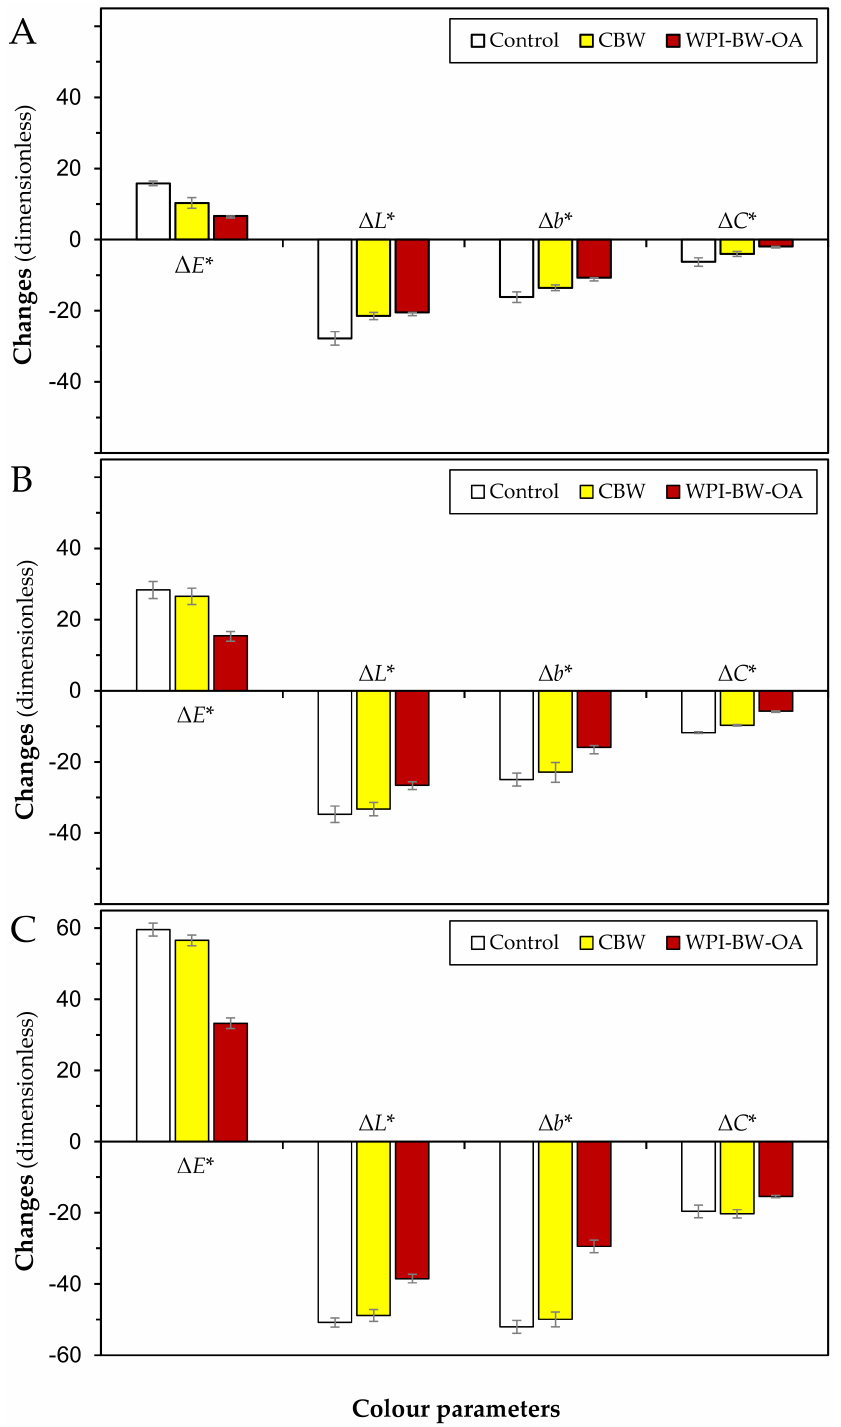
Figure 3. Effect of secondary coating type and storage time (( A ) 30 days; ( B ) 90 days; and ( C ) 180 days) on variation of color changes ( ∆ E* , ∆ L* , ∆ b* and ∆ C* ) in apricot cubes mixed with cereal breakfast. Data are mean of triplicate measurements. Error bars indicate SD values. CBW, chitosan bees wax coating; WPI-BW-OA, Whey protein isolate-bees wax-oleic acid